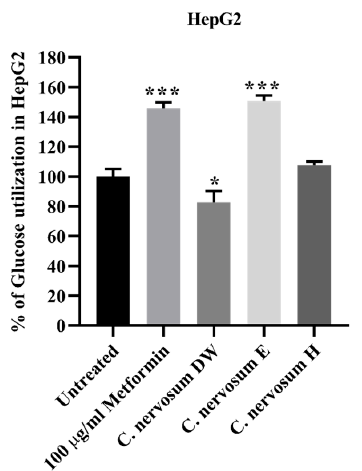
Figure 3. Effect of C. nervosum extracts on glucose utilization in HepG2 hepatocytes. Cells were treated for 48 h. Data are mean ± SD of four independent experiments. *** p < 0.001, * p < 0.05 versus the untreated control.